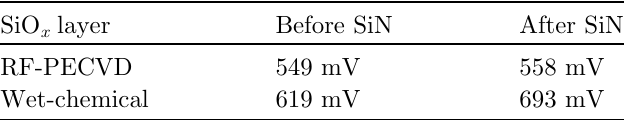
Table 3. Implied Voc of symmetric samples from Batches \( p + ) m c-Si before and 2 and 3 on FZ wafers with wet SiO x :H (no annealing step). after deposition of SiN x